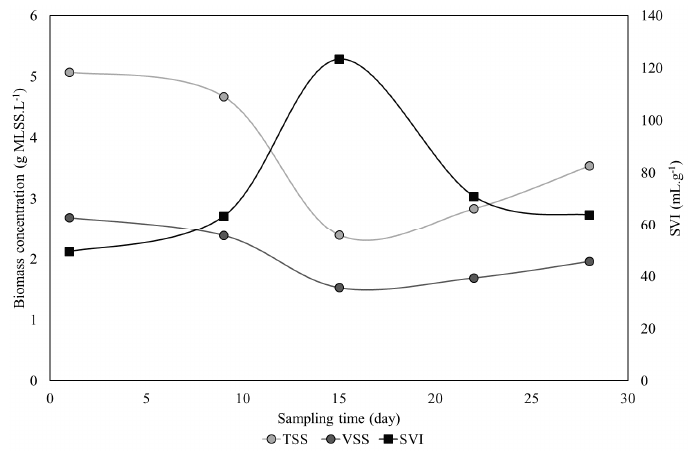
Figure 6. The changes of sludge characteristics during the disturbance. The effects of the shock loads on AS microbial community were illustrated via the increase in SVI values and the drop of biomass concentrations (TSS and VSS).